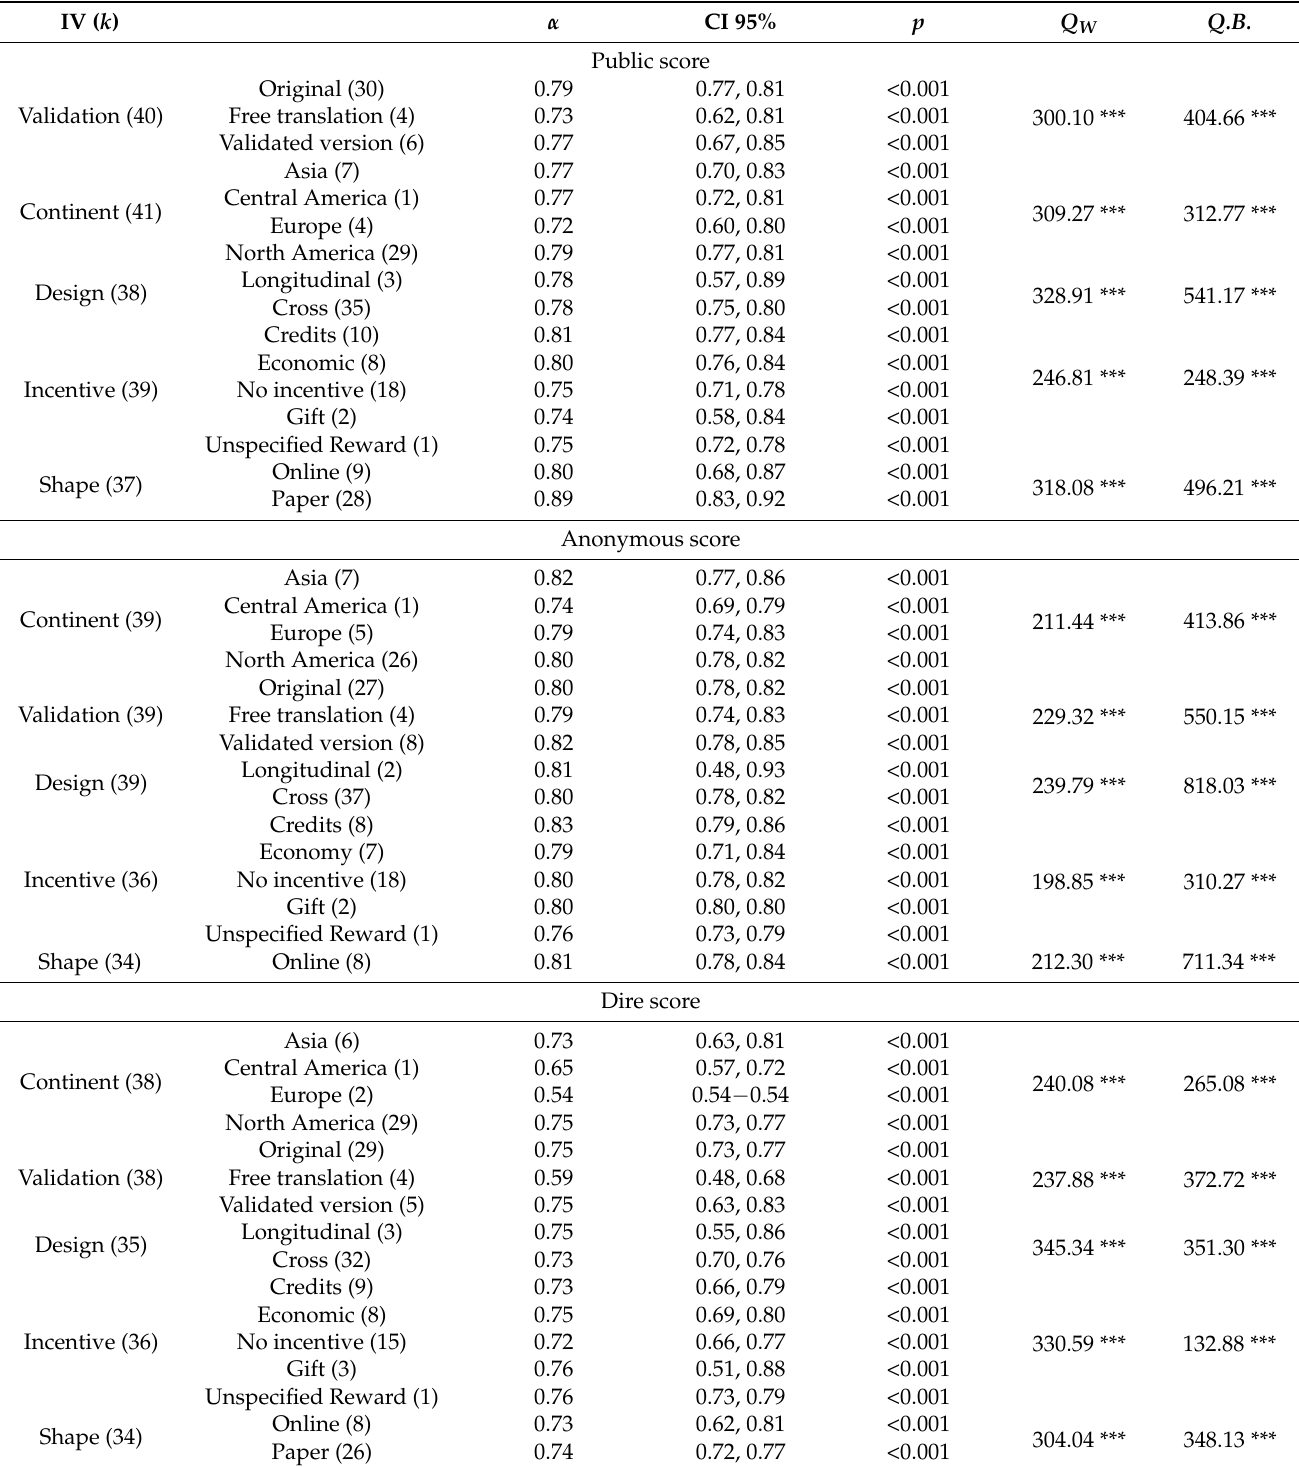
Table 4. Analysis of categorical moderating